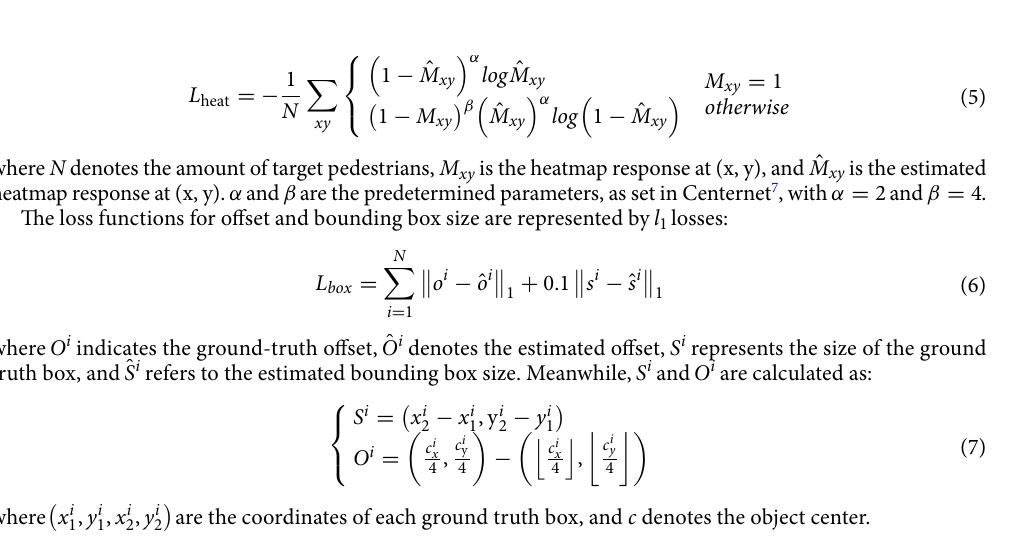
Figure 3. This is